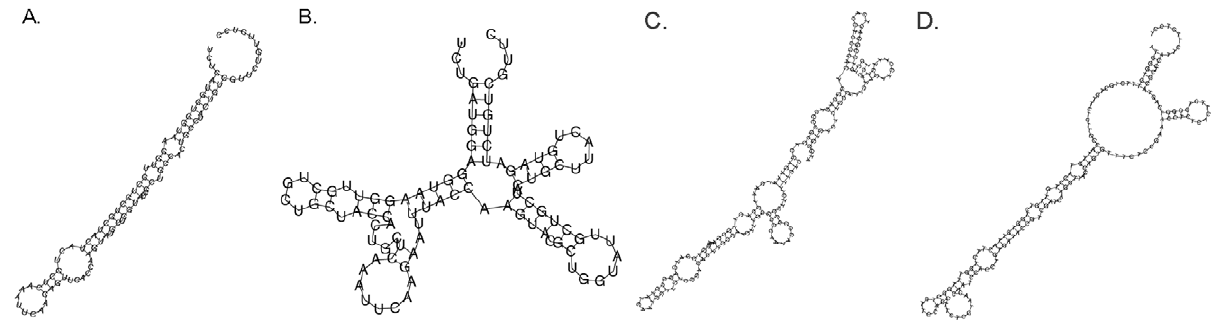
Figure 3. Secondary structure of the first 100-150 bp of original and optimized mRNA generated by the software RNAfolder. A. Structure of original ROL mRNA with the MFE is 2 27.3 kcal/mol and (B) structure of codon optimized ROL mRNA with the MFE is 2 24.5 kcal/mol; (C) Structure of original PhyA mRNA with the MFE is 2 67.8 kcal/mol and (D) structure of codon optimized PhyA mRNA with the MFE is 2 45.9 kcal/mol.